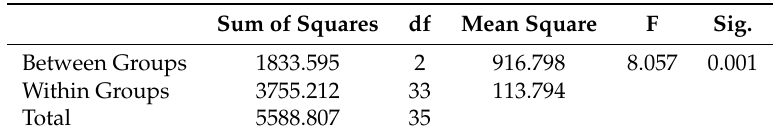
Table 5. ANOVA analysis of Random, NN and our Regression with respect to error rate. Sum of Squares